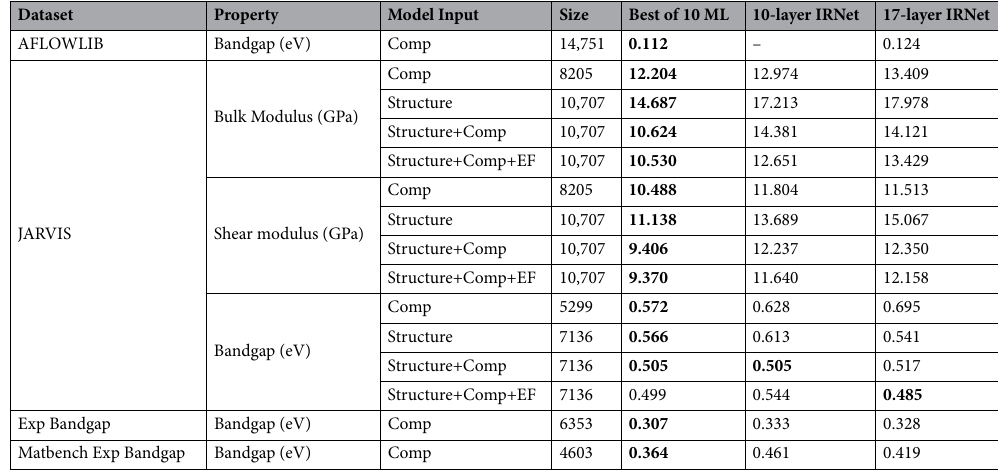
Table 3. Performance of IRNet on smaller datasets. The number in bold font represents the best model performance for a given combination of dataset, materials property and model input (each